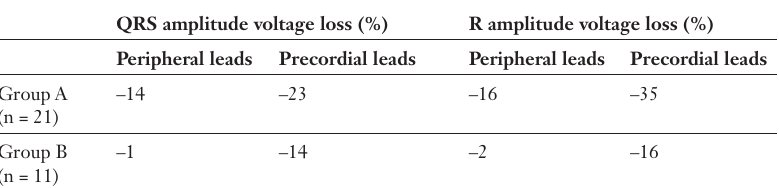
Mean voltage loss after defibrillation affecting the QRS and R amplitude in patients with CAD and ACS (group A) and patients without CAD (group B).